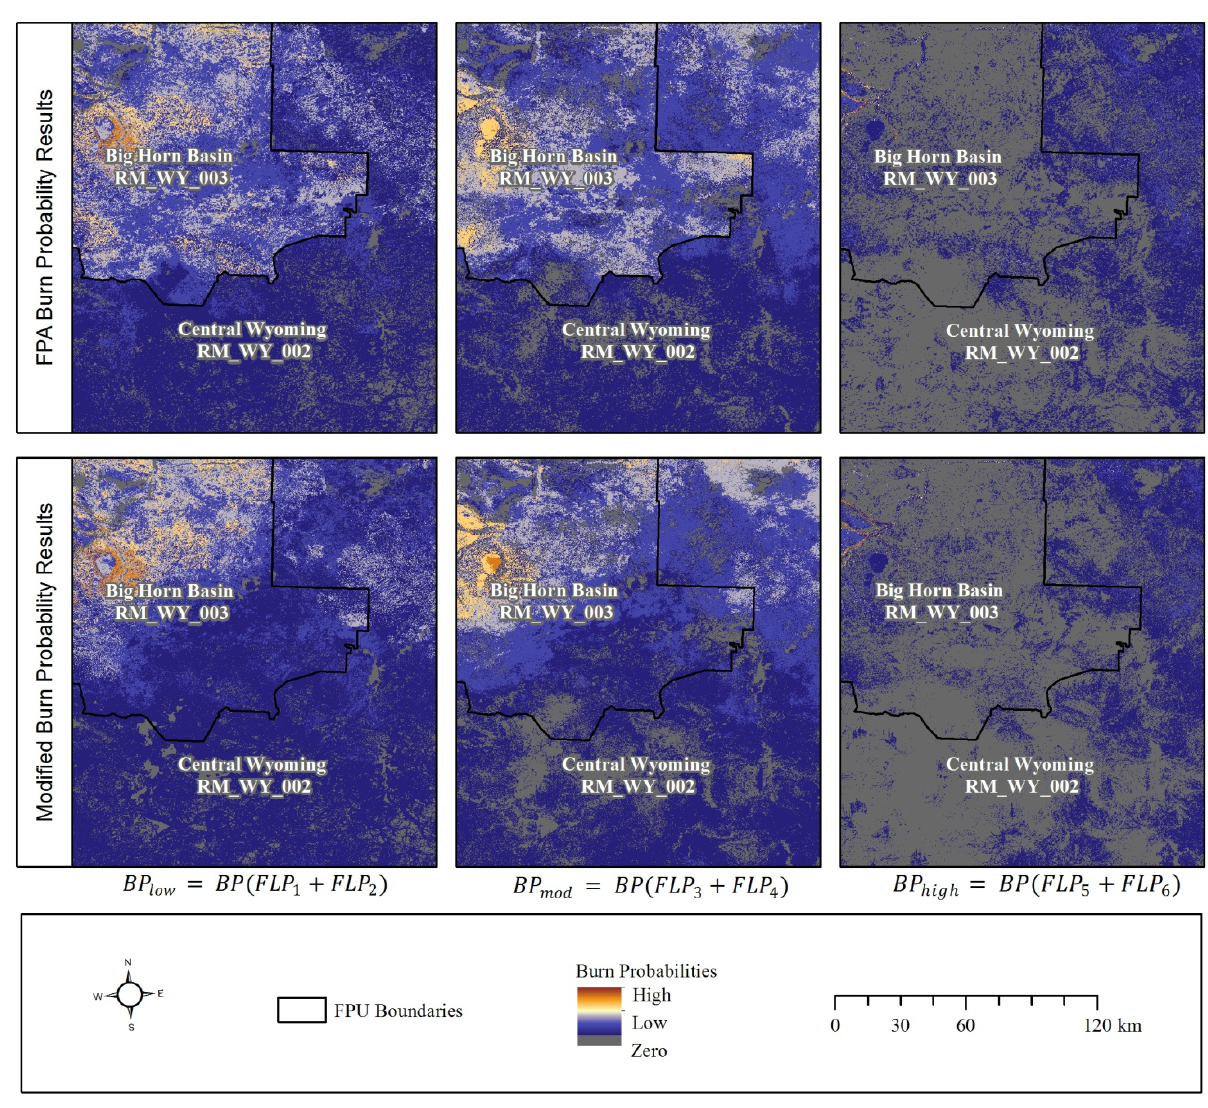
Figure 10. Comparison of unadjusted (top) and modified (bottom) FPA burn probability results. For display purposes fire modeling results are aggregated into three flame length probability (FLP) classes, and mapped across two FPU boundaries [See Equations (1) and